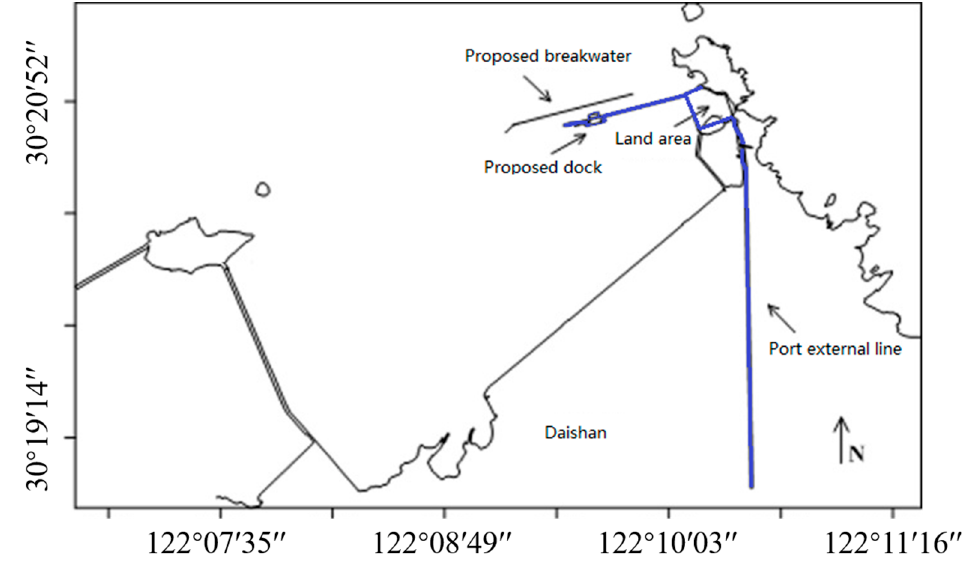
Figure 10. The layout of plan II. Table 3. The differences between plans I and II.